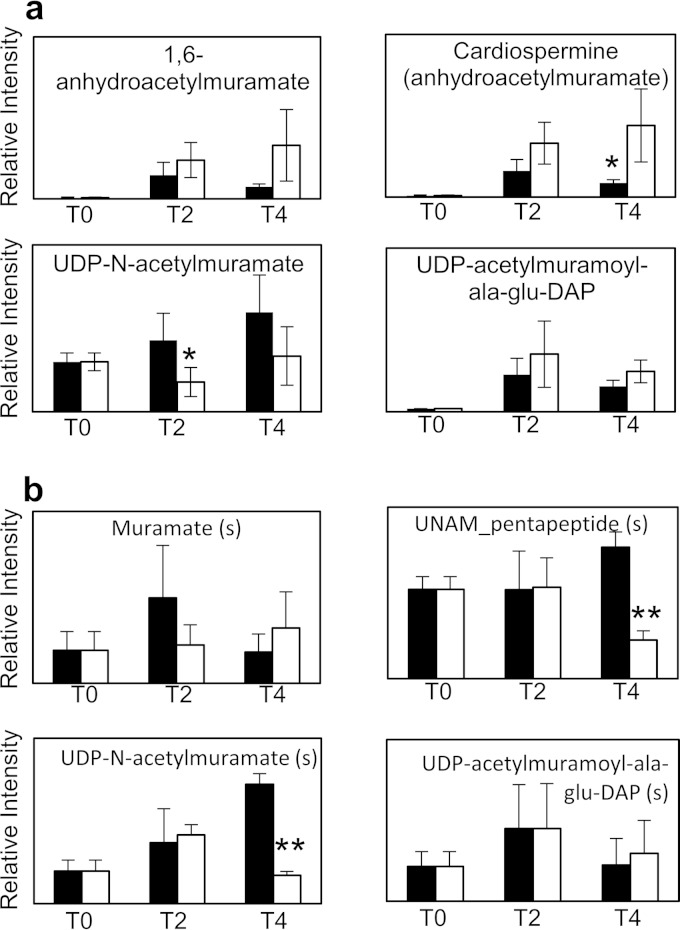
Changes to UDP-N-acetylmuramate and related peptides after ceftazidime treatment. (A) Changes after treatment with 4× MIC ceftazidime; (B) changes after treatment with 8×MIC ceftazidime. *, P value of <0.05; **, P value of <0.001 (Student's t test). “(s)” after the metabolite name indicates a match (mass and retention time) to an authentic standard. Black bars, no-drug control; white bars, treated with ceftazidime. Error bars show standard deviations of the mean.